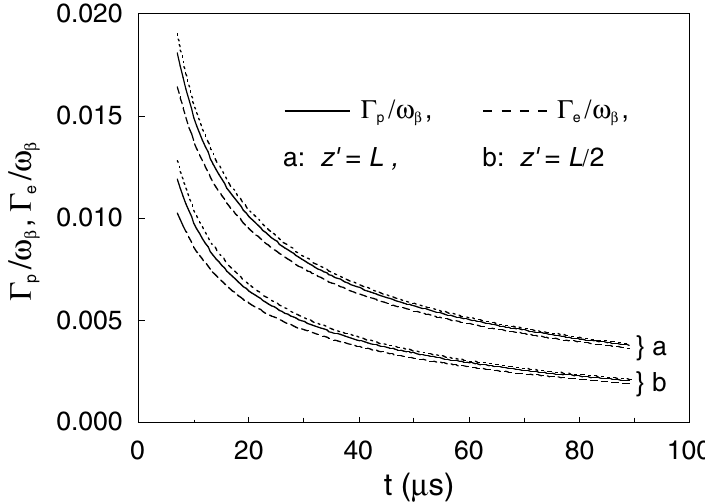
FIG. 3. The growth rates at the tail ( z 0 (cid:1) L ) and the center ( z 0 (cid:1) L= 2 ) of the proton bunch are shown as functions of time. Here, and (cid:20) have been normalized to the betatron frequency ! (cid:20) p e Eqs. (65) and (66), respectively. The dotted curve is computed using the asymptotic approximation in Eq. (67). The parameter values are described in the